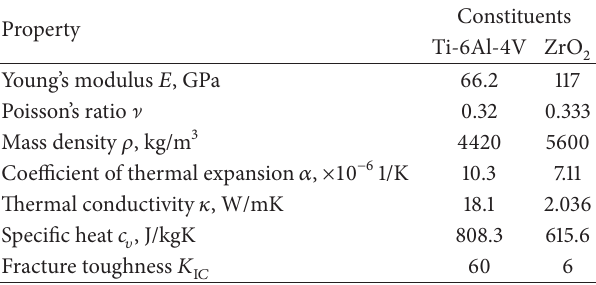
Table 2: Material properties of Ti-6Al-4V and ZrO 2 [28] .